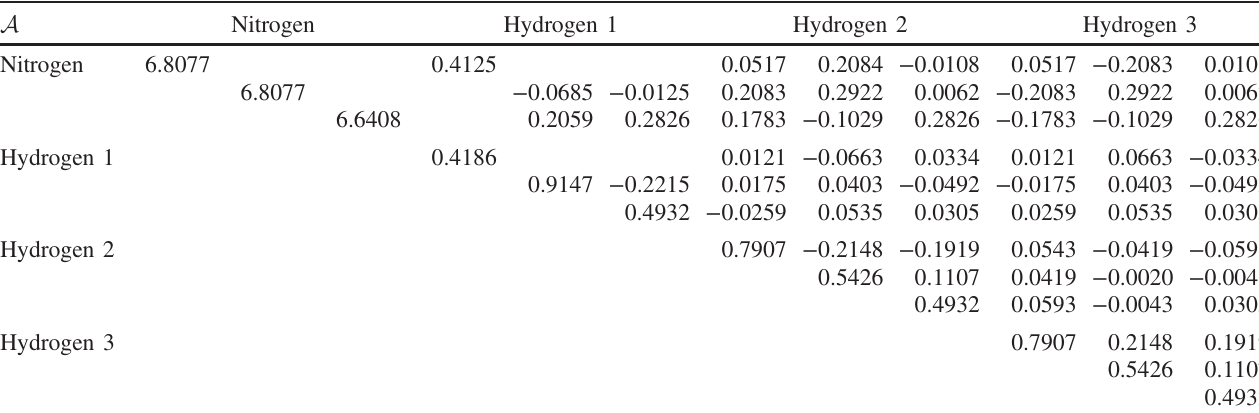
TABLE VII. A matrix for NH 3 . The sum rule yields (9.9965, 9.9965, 9.9991) for i , j ¼ xx , yy , zz , as 10 electrons are present in the